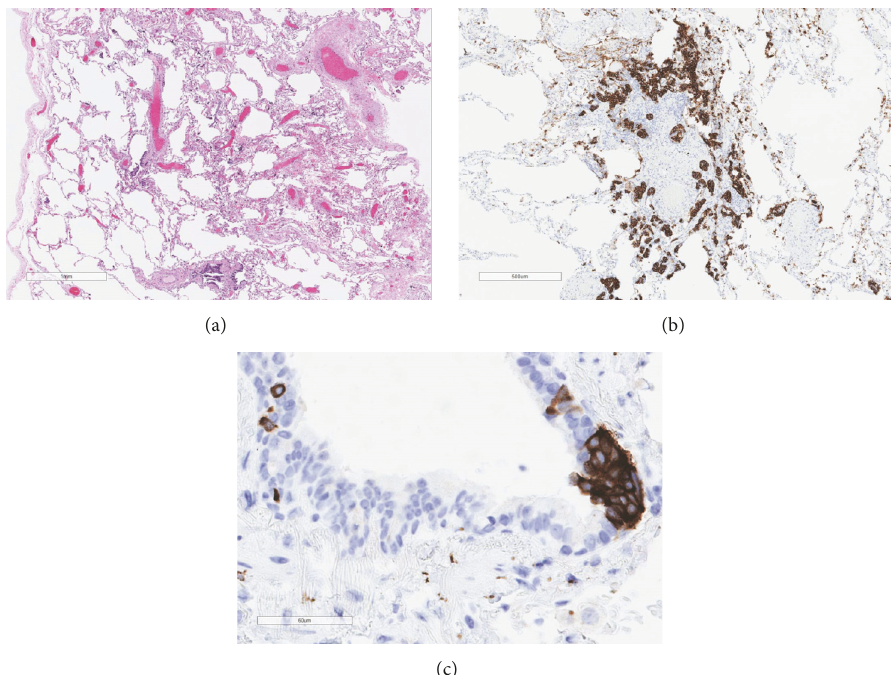
Figure 4: (a) H&E stain 2x showed chronic interstitial pneumonia with alveolar septal thickening and fibrosis, pattern most suggestive of NSIP. (b) Synaptophysin stain 4x showed a carcinoid tumorlet. (c) Synaptophysin stain 40x showed PNEC hyperplasia.